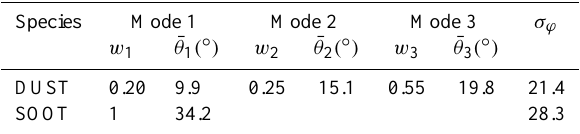
Table 4. Suggested parameters for the parameterization of depo- sition ice nucleation on “generic dust” and soot with low organic carbon content